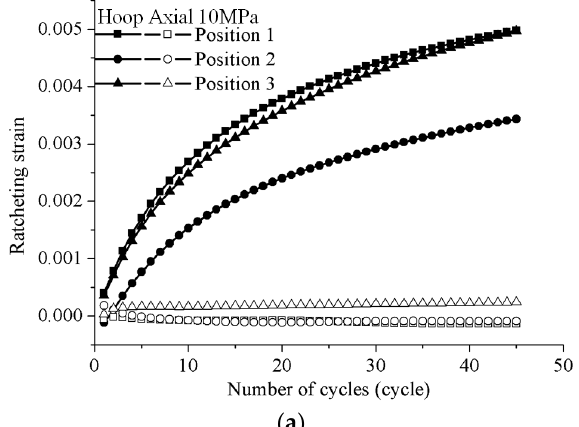
Figure 8. The outside diameter change distribution between Position 1 and Position 3 under different internal pressures after 45 cycles.